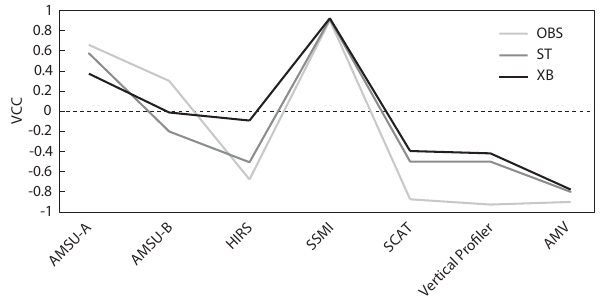
Figure 10. VCC for AMSU-A and AMSU-B, HIRS, SSMI, SCAT, vertical profilers and AMV from XB (black line), ST (dark grey line), OBS (light grey line)